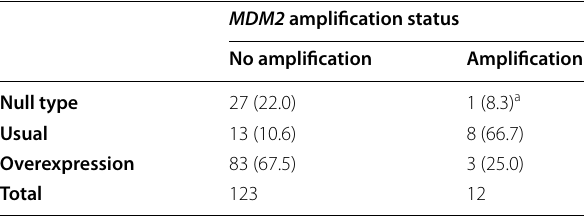
Table 5 Immunohisochemical staining pattern of p53 according to MDM2 amplification status